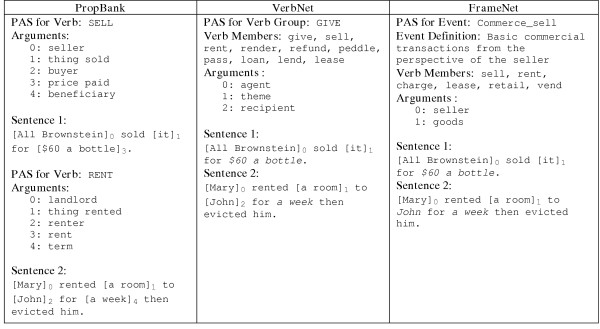
Predicate-argument structures of PropBank, VerbNet and FrameNet. The scheme to assign predicate-argument structures can be varied among different projects due to their different focused applications. This figure shows the differences of predicate-argument structures defined from these three projects: PropBank [22, 23], VerbNet [24] and FrameNet [21]. Similar scheme as PropBank is applied to our PASBio project. Discussion about the reason why we are interested in PropBank scheme is discussed in the main text.